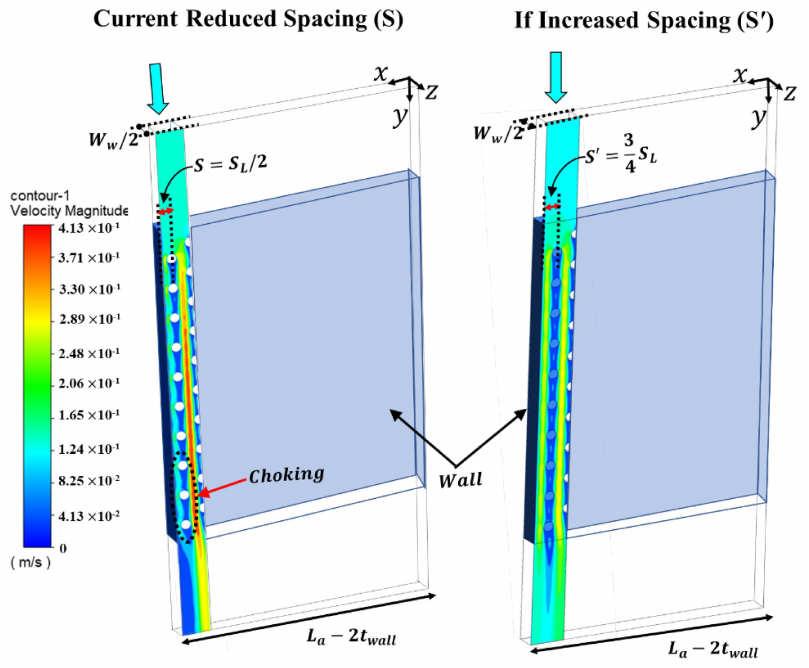
. for different m w . w